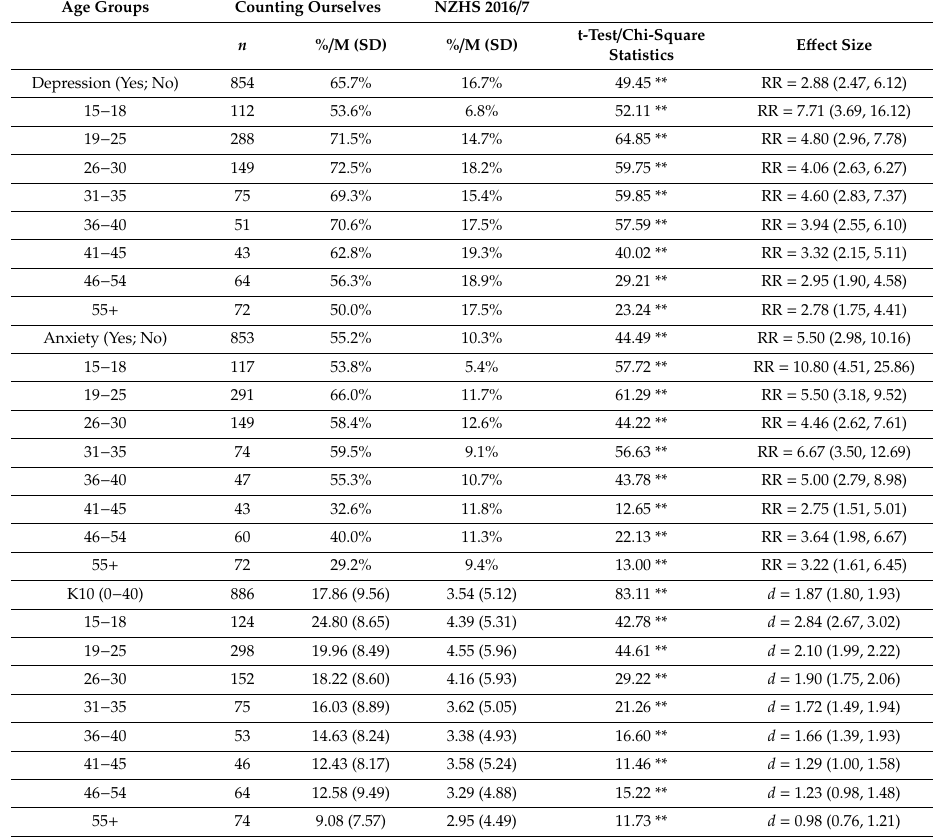
Table 1. Mental health characteristics across age groups and comparisons with New Zealand Health Survey 2016 / 7 (age 15 +